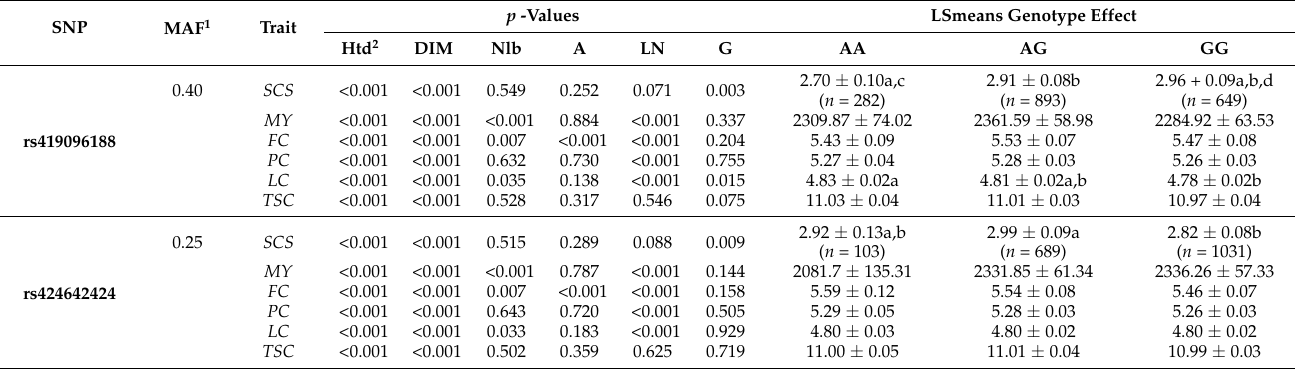
Table 3. Minor allele frequency (MAF), type III test of the fixed effects and covariates, and lsmeans for the genotype effect of the SNPs rs419096188 and rs424642424 for the somatic cell score (SCS), milk yield (MY; mL), fat (FC; %), protein (PC; %), lactose (LC; %) and total solid content (TSC; %) traits. The number of animals for each genotype is indicated in brackets. Different letters indicate significant differences after Bonferroni correction: a, b: p <0.05; c, d: p